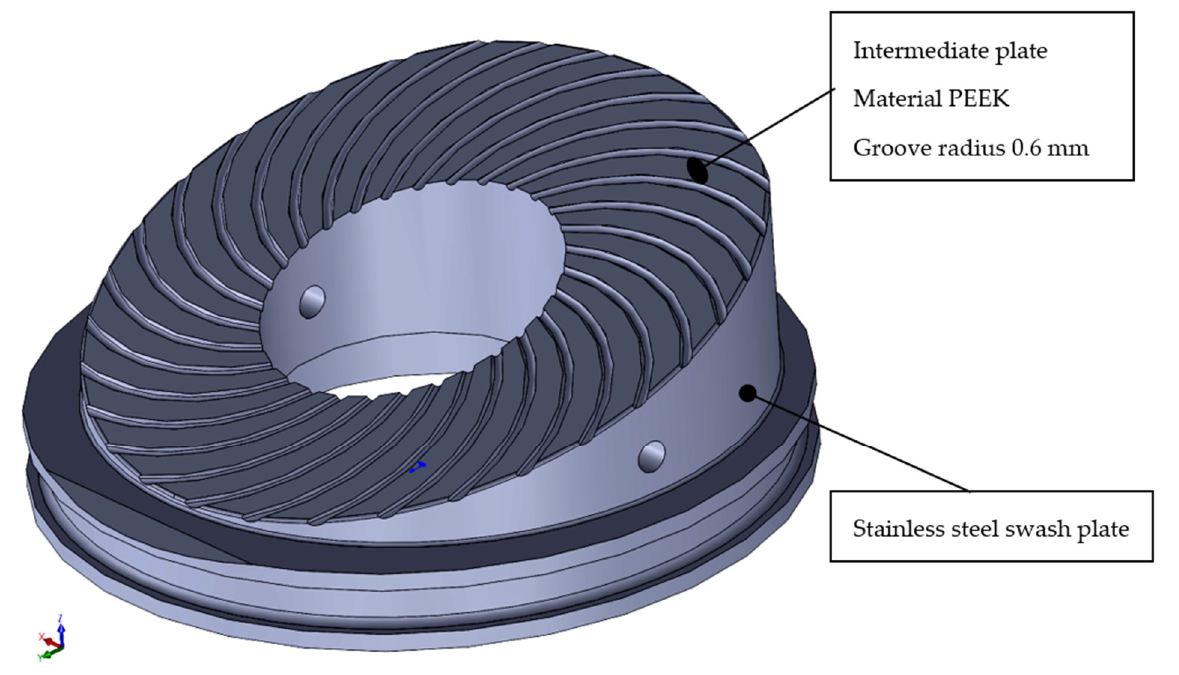
Figure 4. An intermediate and a swash plate of the axial piston pump.